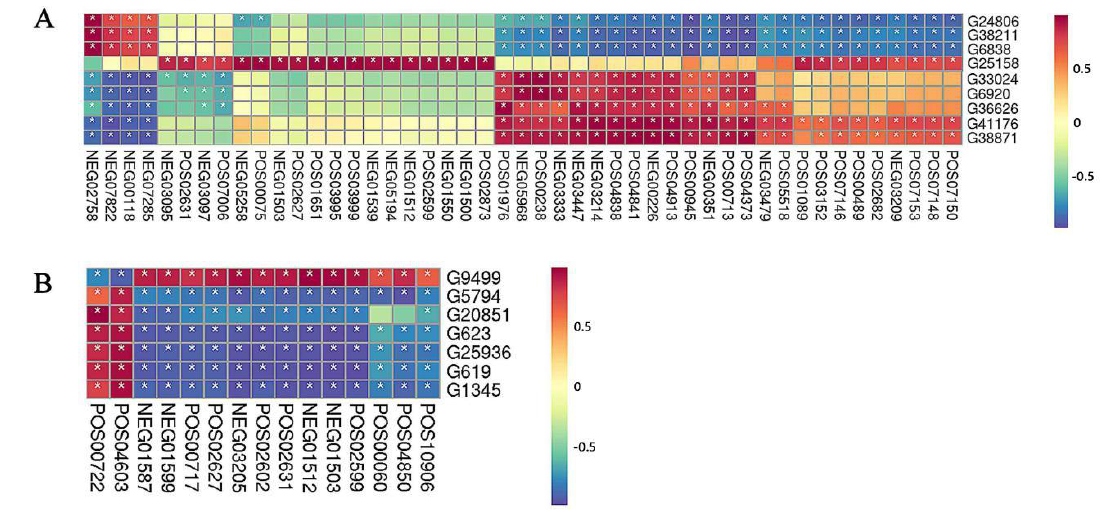
Figure 11. Correlation analysis of DEGs and DAMs. The analysis results of sweetpotato at the growth stages ( A ) S1 and ( B ) S2, respectively. The * marked in the figure represented a significant correlation between DEGs and DAMs. The redder the color, the more significant the positive correlation and the bluer the color, the more significant the negative correlation.